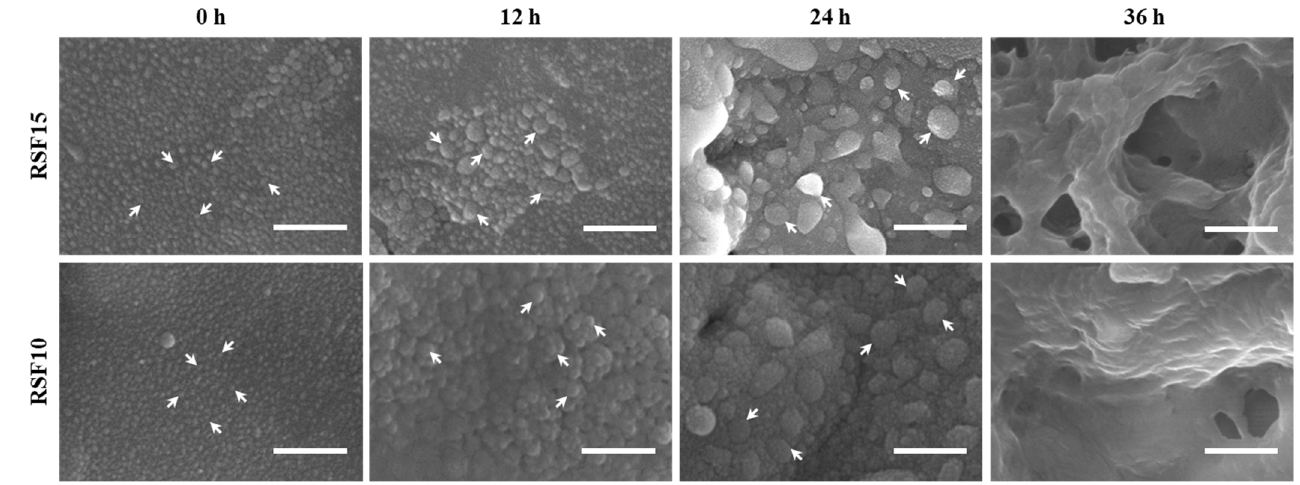
Figure 2. Morphologies of silk fibroin sol-gel transformation process. Scale bar is 500 nm.